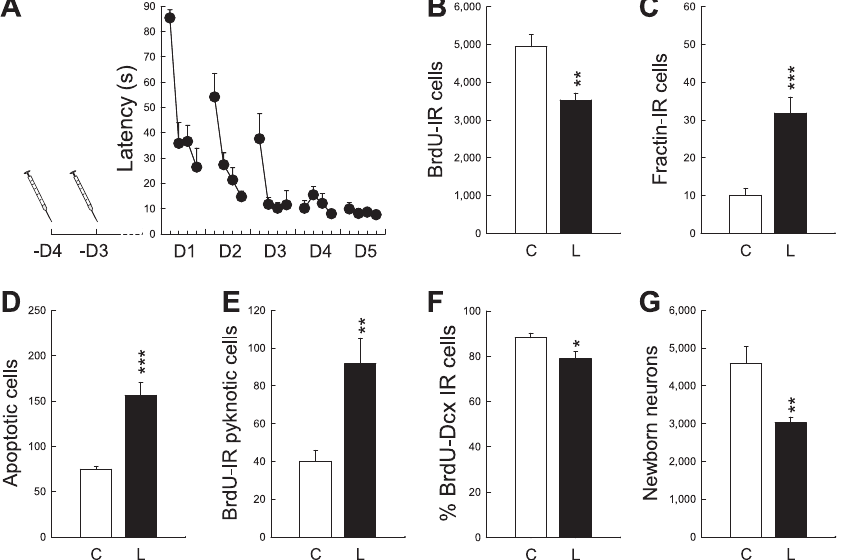
Figure 5. Spatial Learning Promotes the Death of Newborn Neurons Generated a Few Days before Training (A) Latency to find the escape platform. Learning groups were injected with BrdU either 4 or 3 d before initiation of training as indicated by the syringes. D, day. (B) Newly born cells measured by the number of BrdU-IR cells. (C and D) Apoptotic cells measured by the number of fractin-IR cells (C) and both pyknotic and karyorrhexic dying cells (D). (E) Number of BrdU-IR cells exhibiting characteristics of dying cells. (F) Percentage of BrdU-IR cells expressing the immature neuronal marker Dcx. (G) Extrapolated number of newborn neurons. A single asterisk (*) indicates p (cid:2) 0.05, double asterisks (**) indicate p (cid:2) 0.01, and triple asterisks (***) indicate p (cid:2) 0.001 compared to Control groups. Error bars represent the